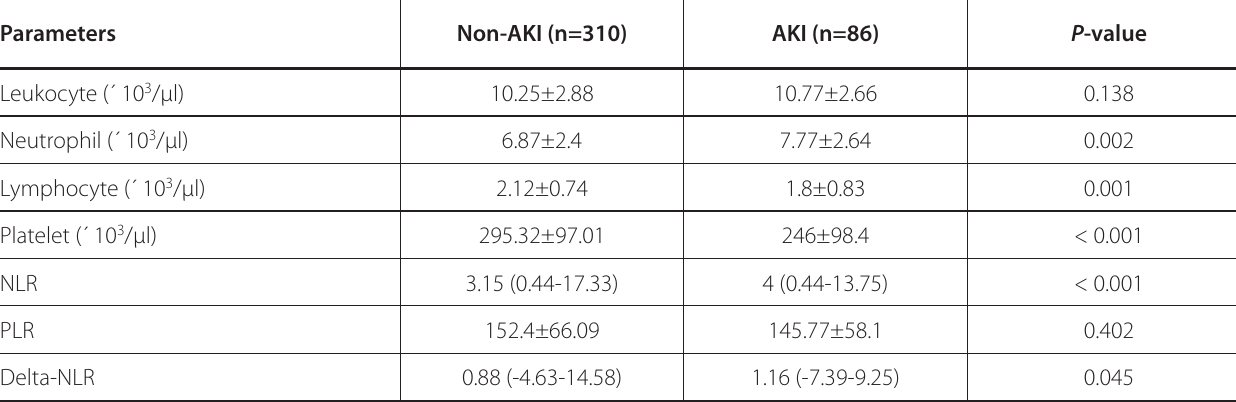
Table 3 . The relation between the parameters and AKI at the day of discharge. Parameters